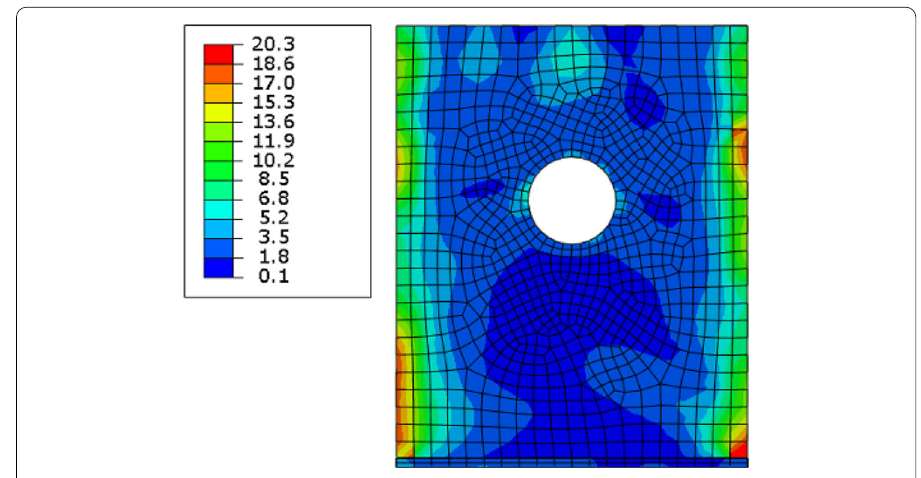
Fig. 11 Single hole feature model in